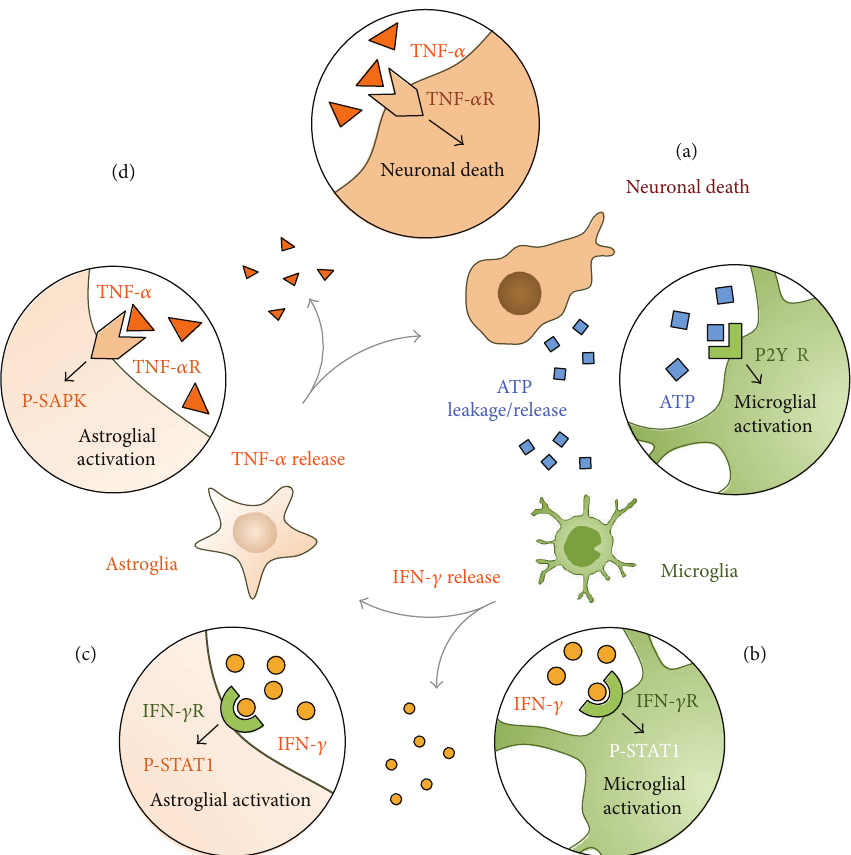
Figure 4: Diagram of the hypothetical vicious cycle of glial activation signaling triggered in Parkinsonism during dopaminergic neuronal loss. (a) Dopaminergic neuronal death induces the release or leakage of ATP, which activates microglial cells through P2YR. (b) Activation of microglia induces the release of IFN- 𝛾 , which binds IFN- 𝛾 R in neighbor microglial and astroglial cells initiating the phosphorylation of STAT1. (c) Activation of astrocytes involves the release of TNF- 𝛼 , which may activate astrocytes through the activation of TNF- 𝛼 R by phosphorylating SAPK. (d) Importantly, released TNF- 𝛼 may also activate TNF- 𝛼 R present in dopaminergic neurons, which may induce new neuronal